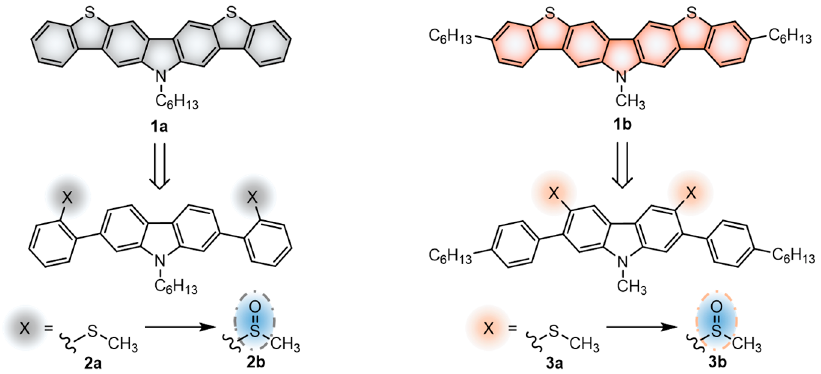
Figure 1. Schematic representation of the retrosynthetic approach towards compounds 1a – b and their respective synthetic precursors 2a – b and 3a – b .